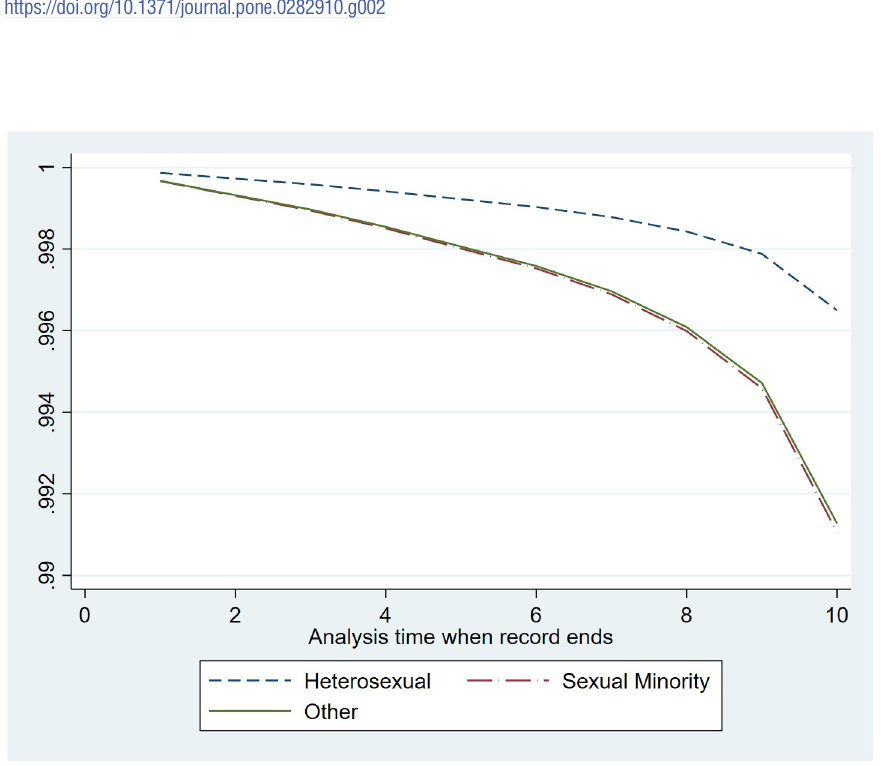
Fig 3. Cox regression curves modeling time to SRB event for women by sexual orientation.